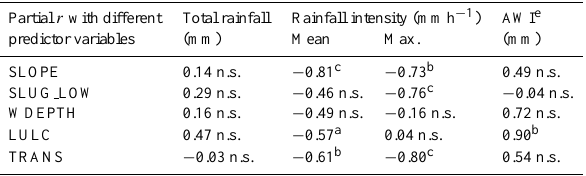
Fig. 4. Explained variance of random forest models for different temporal scales: entire time series, seasonal scale (highlighted in grey), and event scale. Top graph: explained variance of random for- est models predicting the water table response variables WT NORM and INDEX ACTI . Bottom graph: explained variance of random for- est models predicting the water table response variable WT NORM for all wells ( n = 90), only the grassland hillslope wells ( n = 30), and only the forest hillslope wells ( n = 60). The y-axis is scaled to a minimum of 0, missing bars represent 0% explained variance or negative